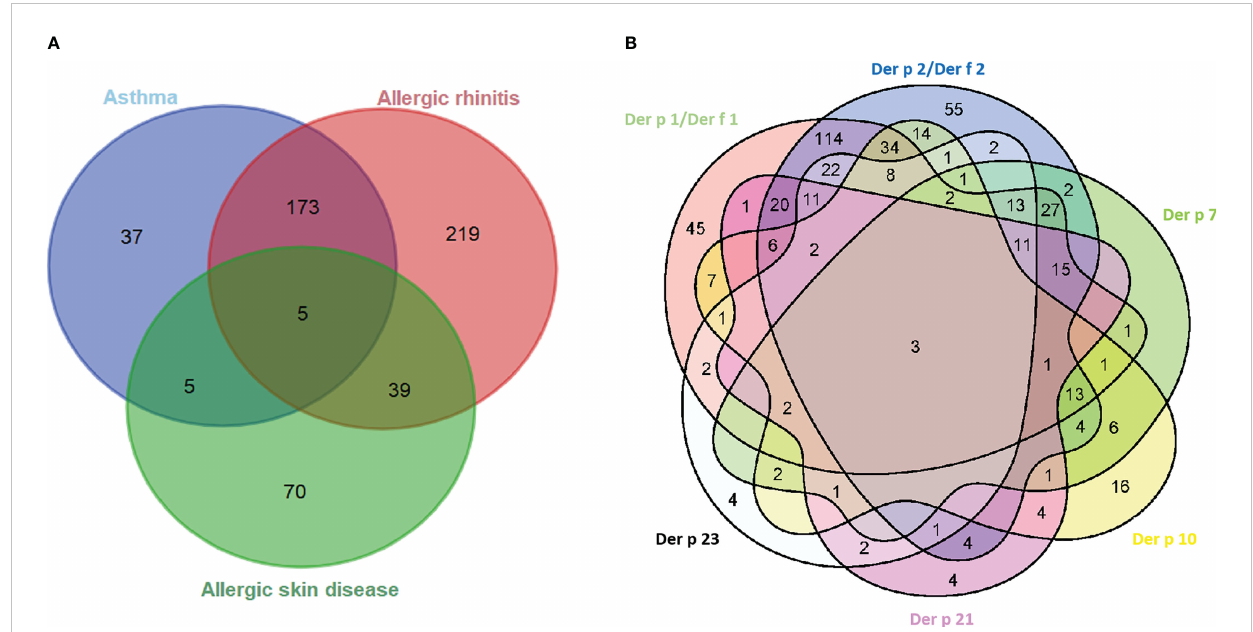
FIGURE 2 Venn diagrams of the interrelation of allergic symptom groups (A) and sensitized allergens (B) . Der p 1/Der f 1 and Der p 2/Der f 2 groups mean one or both of the components are positive.